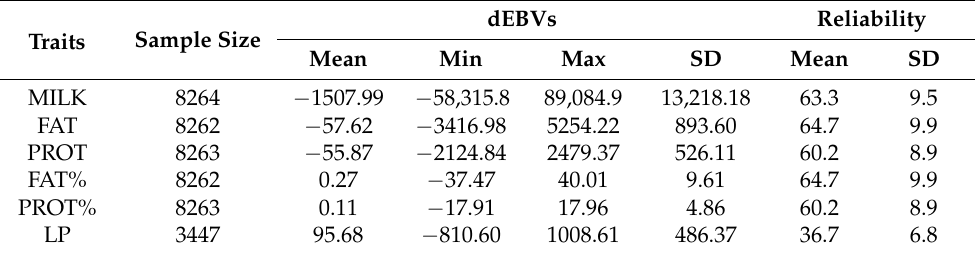
Table 1. Summary of the pseudo-phenotypes (de-regressed estimated breeding values, dEBVs) for milk (MILK), fat yield (FAT), protein yield (PROT), fat percentage (FAT%), protein percentage (PROT%), and lactation persistency (LP) in North American Holstein